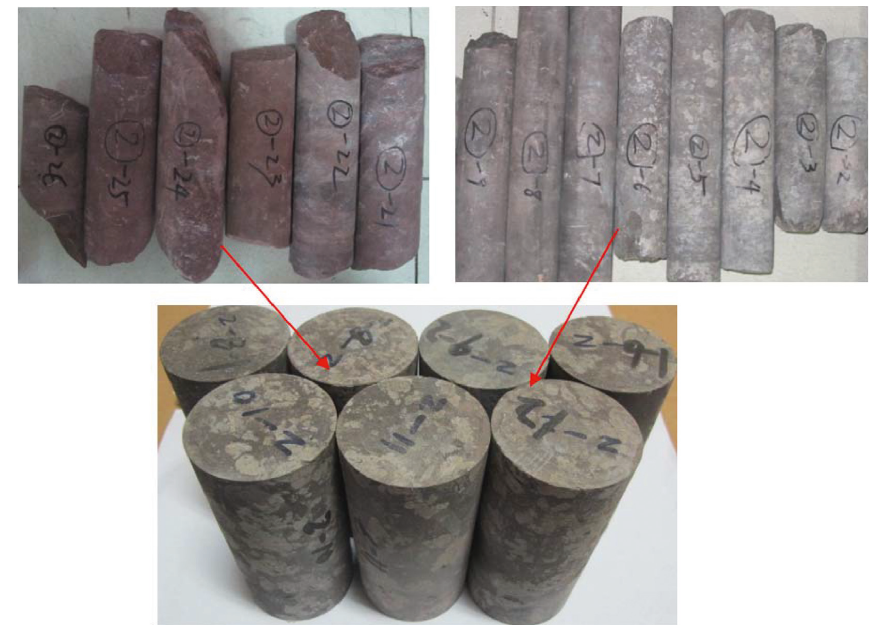
Figure 6: The part of the samples for uniaxial compressive